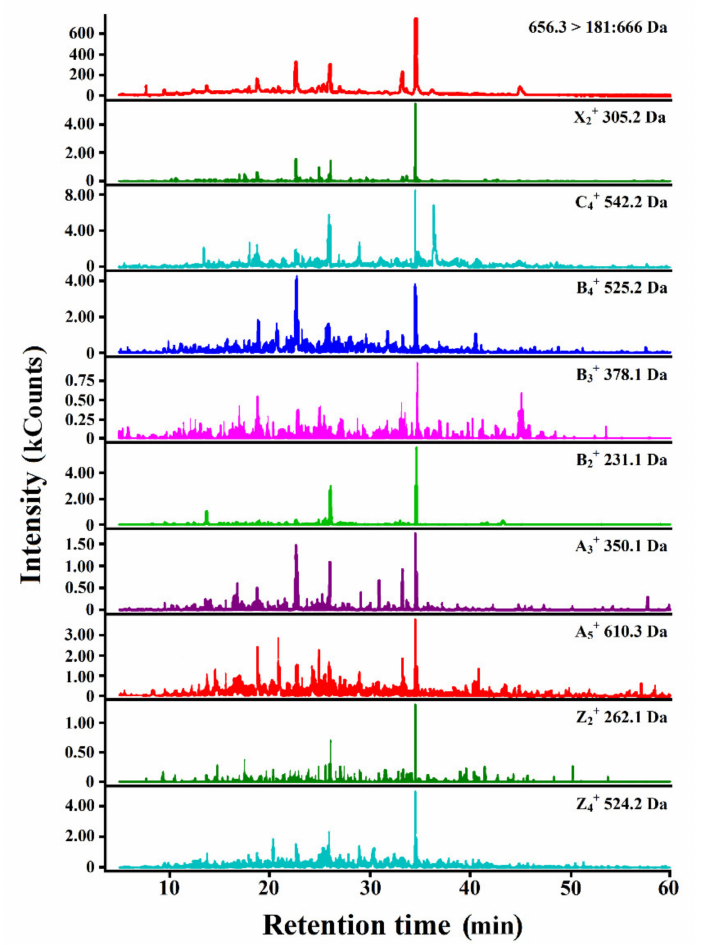
Figure 3. LC-MS / MS chromatograms of total ion current (upper chromatogram–656.3 > 181: 666 Da) and daughter ions of the DD FFL peptide matching the β -conglycinin ( β -chain) fragment identified among products of hydrolysis of soybean protein concentrate by ficin. Nomenclature of daughter ions according to Roepstor ff and Fohlman